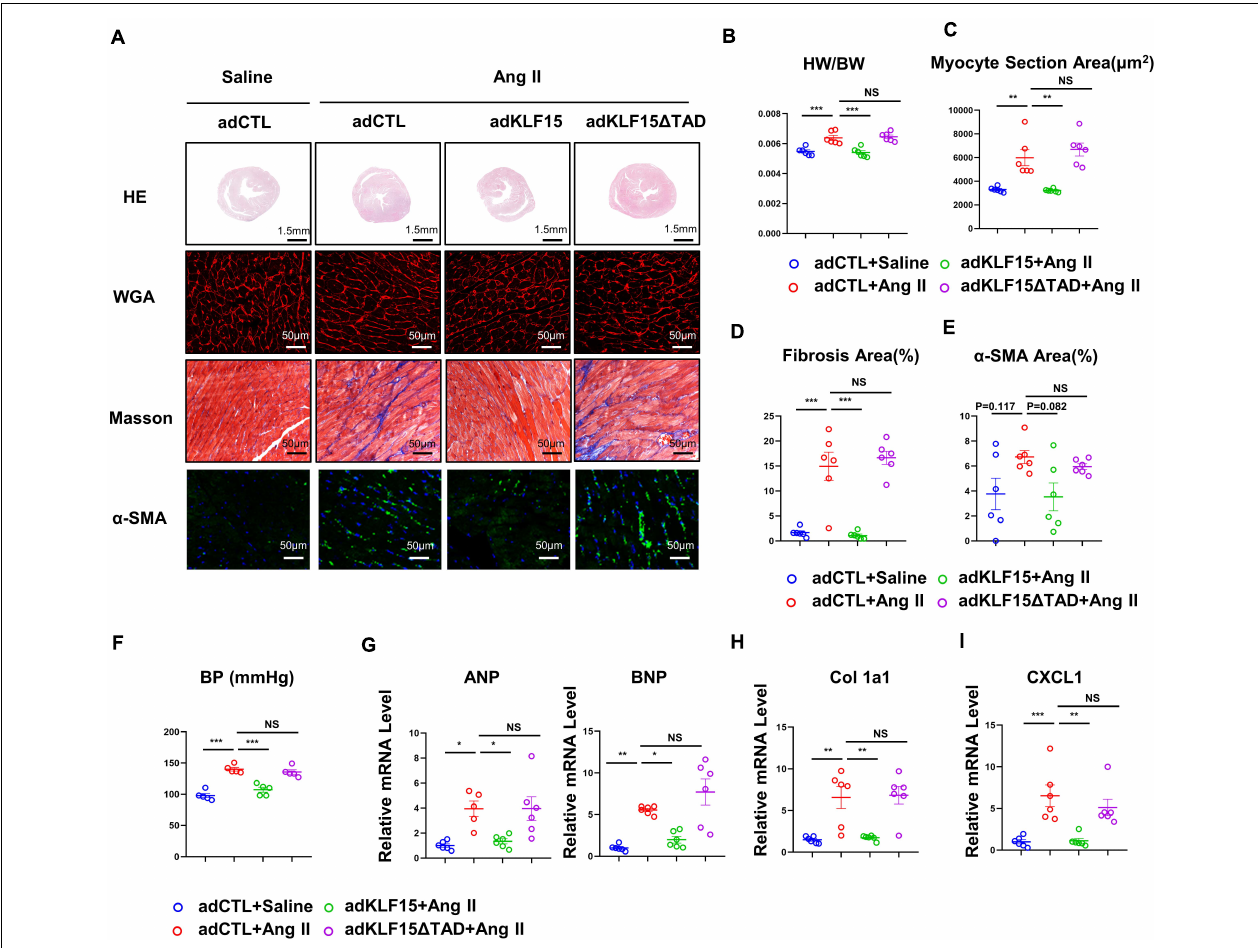
FIGURE 5 | KLF15 improved Ang II-induced cardiac remodeling through TAD. AdCTL, AdKLF15 and Ad KLF15- (cid:49) TAD-infected mice were infused with saline or Ang II for 14 days. (A) Representative heart size, WGA stain, Masson stain and α -SMA immunofluorescence image. (B) Statistical analysis of heart weight/body weight ratio. (C) Quantification analysis of myocyte section area. (D) Quantification analysis of fibrotic area measured by Masson stain. (E) Quantification analysis of α -SMA positive area measured by immunofluorescence. (F) Statistical analysis of blood pressure. (G–I) qPCR analysis of mRNA levels of ANP, BNP, Collagen 1a1 and CXCL1. * P < 0.05, ** P < 0.01, and *** P <